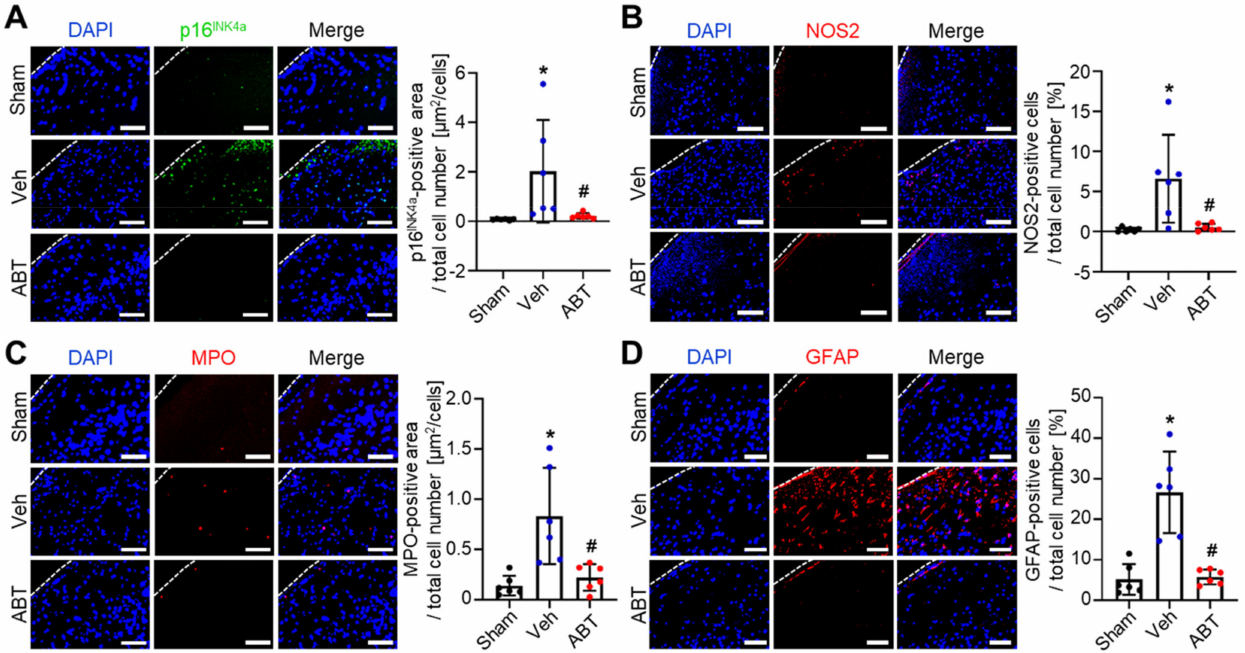
Figure 3. Removal of senescent cells and attenuation of inflammation in ischemic stroke lesion by ABT263 in middle cerebral artery occlusion (MCAO) ischemia-reperfusion rat model. MCAO rats were treated with intravenous injection of either vehicle (Veh) or ABT263 (ABT). The sham group did not receive MCAO. Immunostaining for ( A ) p16 INK4a , ( B ) NOS2, ( C ) MPO and ( D ) GFAP in the ischemic stroke lesion of MCAO rats on day 4. ( A – D ) Scale bars, 100 µ m. n = 6 per group. Data are presented as mean ± SD. * p < 0.05 compared to Sham, # p < 0.05 compared to Veh. One-way ANOVA with Tukey’s post-test was used for statistical